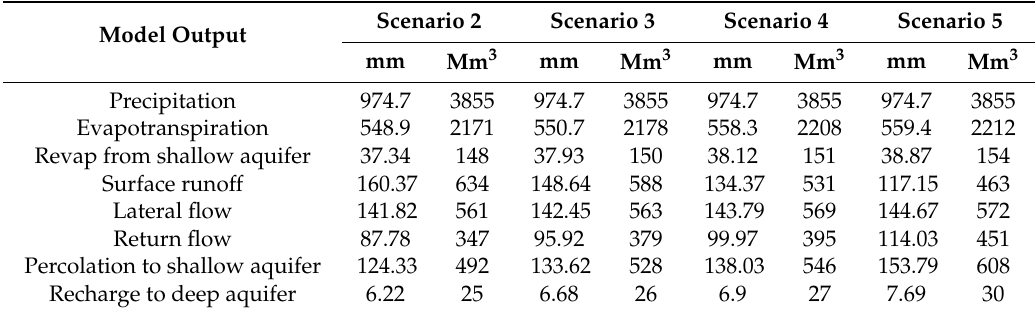
Table 3. Water balance values—annual means for the period 1992–2013 in mm (millimeters) and Mm 3 (millions of cubic meters) for Scenarios